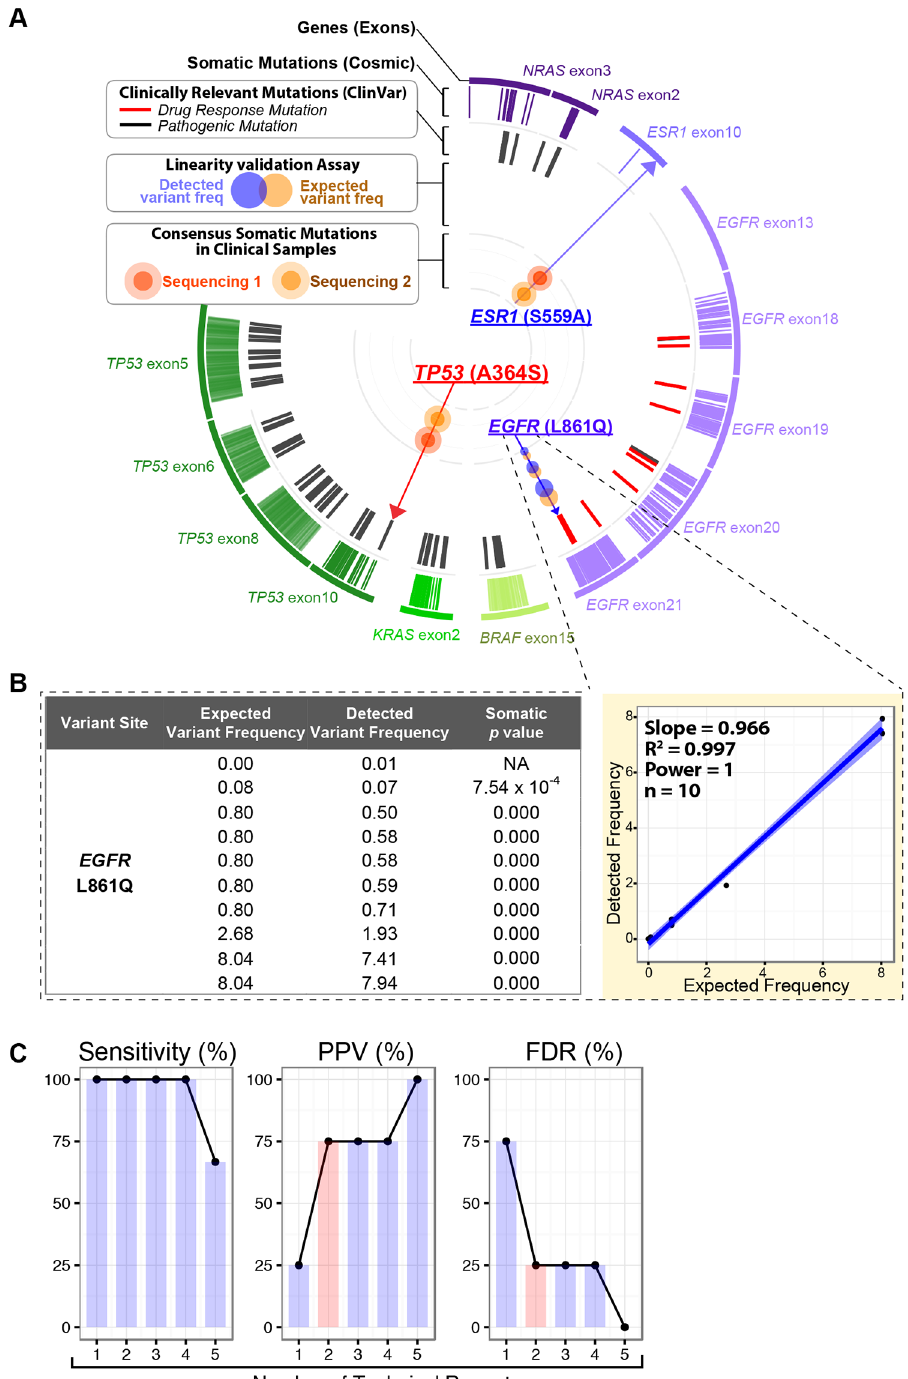
Fig 5. Sequencing target regions and the sequencing results. (A) Descriptionsfrom outer track to inner track are as follows: Track 1 (target genesand exons sequenced); Track 2 (somatic mutations): The bars indicatesomatic mutations reportedin the COSMIC database; Track 3 (clinically-relevant mutations): The bars represent clinicallyrelevant mutations reportedin the ClinVardatabase; Track 4 (validation assay): The interlaced dots indicatethree representative sequencing results of simulatedCTC samples. The size of the dots is proportional to the frequency. See (B) for the correlationbetweenfrequencies. Track 5 (consensus somatic mutations detected in the clinical samples): library preparation and sequencingof CTC